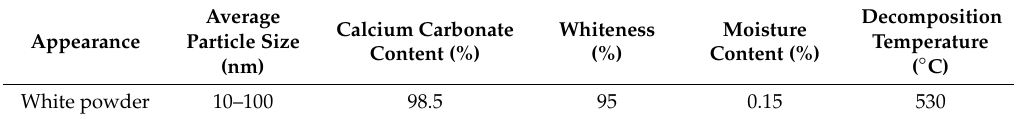
Table 2. Characteristics of nano-CaCO 3.